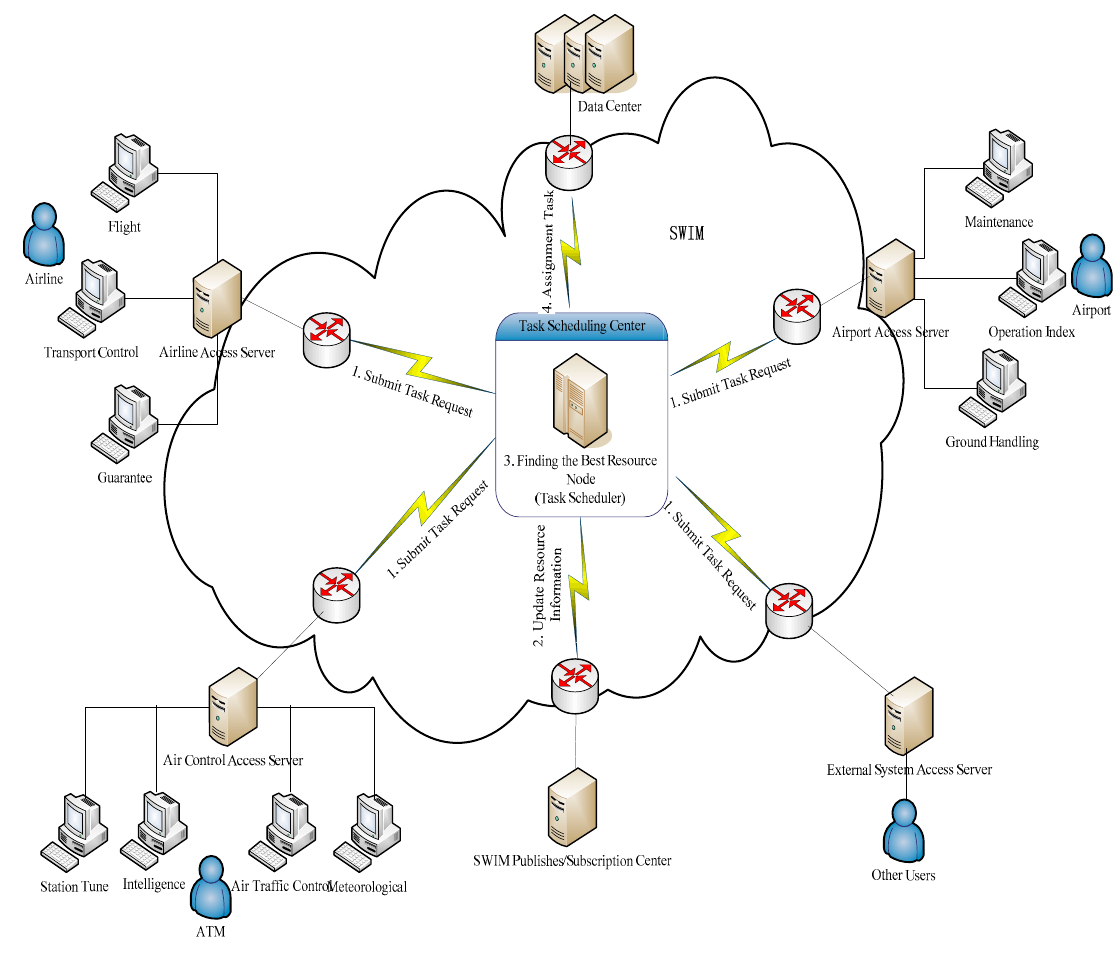
Figure 3. SWIM task scheduling structure diagram.